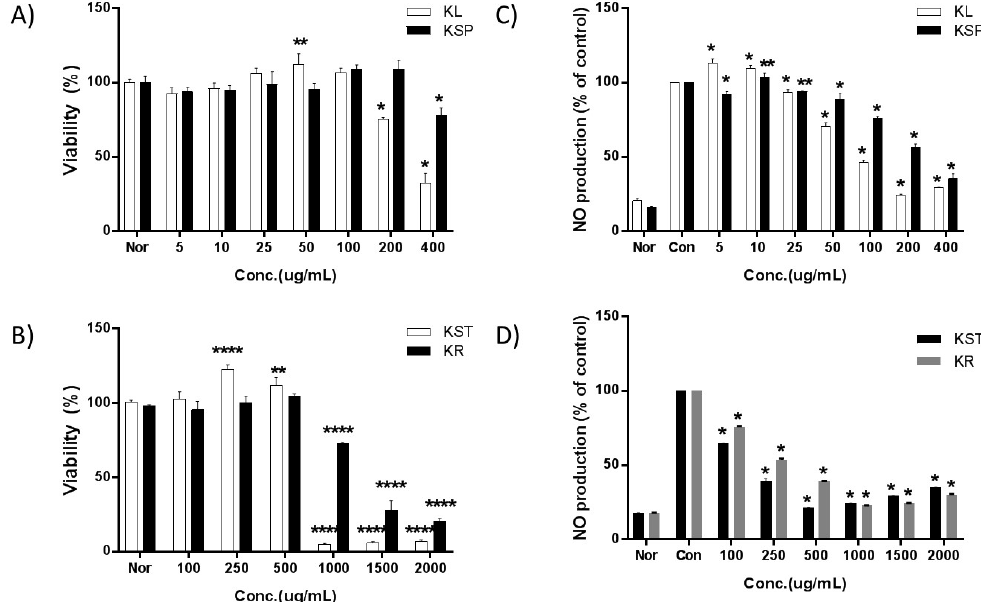
Figure 1. Effects by extraction parts of kudzu on the viability and NO levels of RAW 264.7 macrophages. A density of 1 × 10 4 cells/well of macrophages were seeded in a 96-well plate and incubated with various concentrations of each extract for 24 h and cell viability was determined by MTT